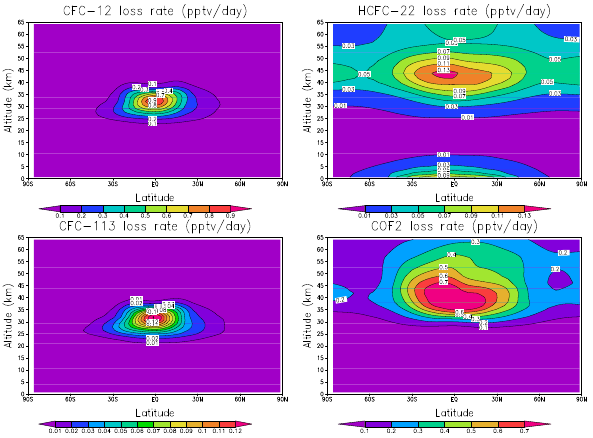
Figure 10. Average loss rates (annual mean zonal mean; pptvday − 1 ) calculated by SLIMCAT for COF 2 and its three main source gases, CFC-12, HCFC-22, and CFC-113. Full details of the loss mechanisms are provided in the